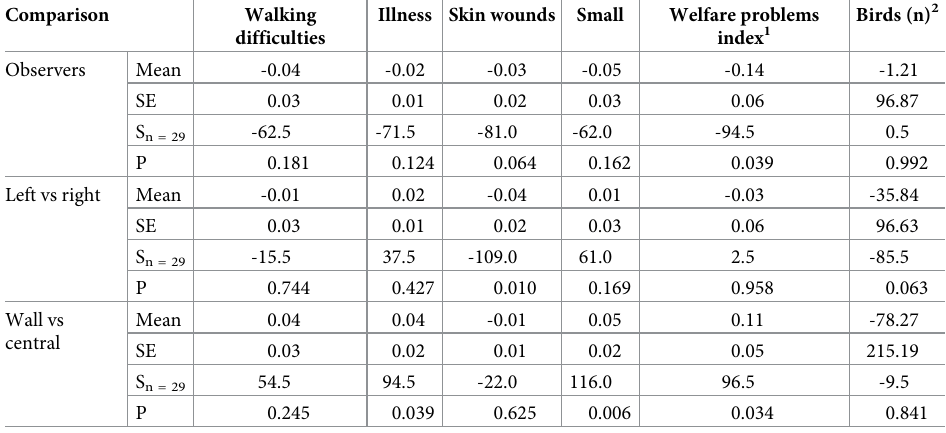
Table 7. Mean differences in prevalence of welfare problems (%) between transects according to observer identity and transect location (left minus right; wall minus central), with Wilcoxon signed-ranks test (S) results.